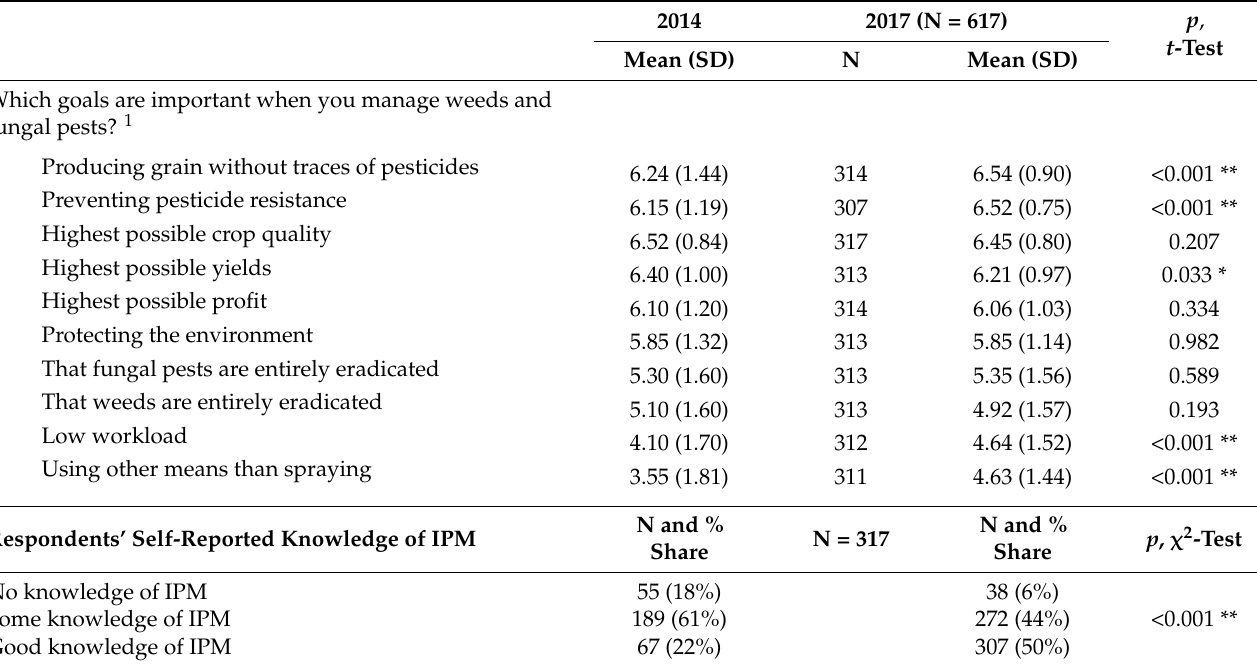
Table 2. Differences in farmers’ goals and knowledge prior to and after IPM became